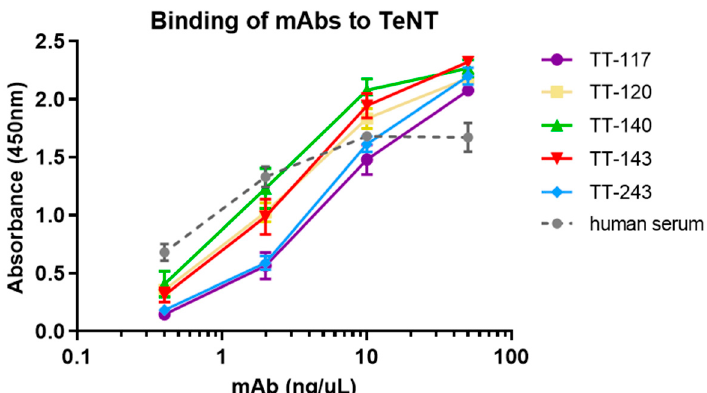
Figure 3. Binding of mAbs to TeNT by ELISA. The mAbs were tested in the 0.4 to 50 ng/mL range. The serum of a vaccinated individual was used as a control in dilutions from 1:2 to 1:16. The graph represents the mean and SD of the absorbance measured in the purified samples of each mAb cultured under four selection conditions. Table 1. Ka, kd, and KD(M) were calculated from each mAb by kinetic and steady-state affinity assay.